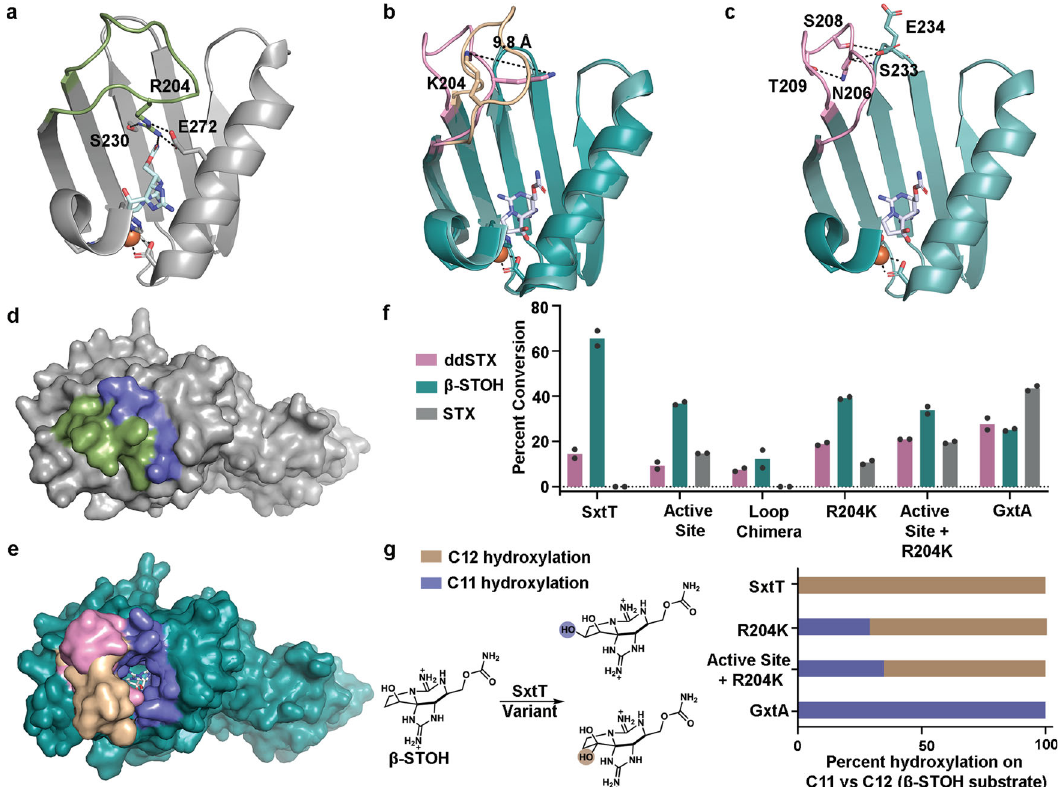
Fig. 3 Identi fi cation of a second structural region in SxtT and GxtA that is involved in selectivity. Different conformations of a fl exible loop that connects the β 13 and β 14 strands of a SxtT and b GxtA are observed in each substrate-bound structure. In SxtT this loop (green) interacts with the substrate as well as Ser230 and Glu272. In GxtA, this fl exible loop is found in two different orientations (pink and wheat). The difference between the position of Lys204 on these loops is 9.8 Å. c The pink loop orientation shown in panel b interacts with residues Ser233 and Glu234 on the surface of the protein. d A surface rendering of SxtT with β -STOH bound shows that the loop (green) closes the entry (blue) into the active site. e A similar surface rendering of GxtA reveals that the different observed loop orientations (pink and wheat) extend away from the active site and leave the entrance (blue) wide open. f A chimeric variant in the loop region of SxtT (F200V, Q201H, R204K, I205F, V206N, S207N, H208S, I209T, E210K, and W214M) shows low levels of activity on ddSTX and β -STOH, whereas the single R204K loop variant is able to hydroxylate ddSTX, β -STOH, and STX. Similarly, the creation of a triple variant that combines residue changes at the R204 position with changes in the active site region (M255Y and T276V) ampli fi es the ability to hydroxylate STX. g As evidenced by incorporation of ethanol into the reaction product, a mixture of hydroxylation at the C11 (purple) and C12 (brown) positions is observed with the R204K and M255Y/T276V/R204K variants when β -STOH is used as a substrate. In panels f and g , data were measured using n = 2 independent experiments. In panel g , data are presented as the mean value of the measurements. In all panels, ddSTX corresponds to dideoxysaxitoxin, β -STOH corresponds to β -saxitoxinol, and STX corresponds to saxitoxin. Source data are provided as a Source Data fi